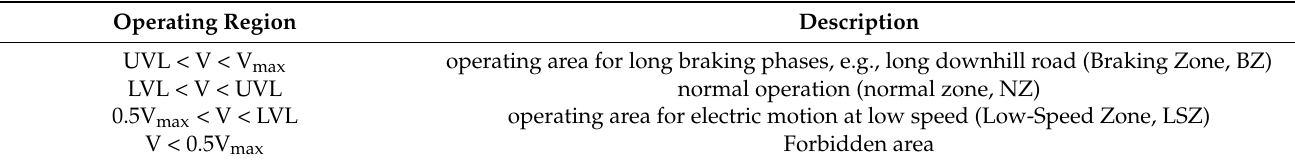
Table 4. Four operating areas